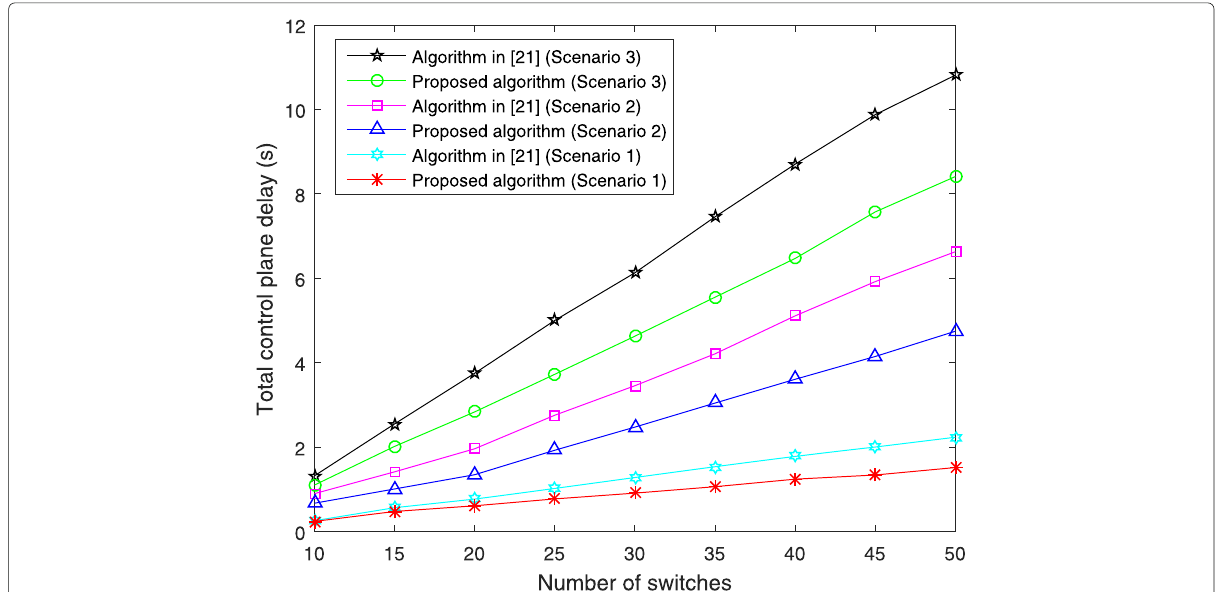
Fig. 6 Control plane delay versus the number of switches (different scenarios). The control plane delay versus the number of switches for different